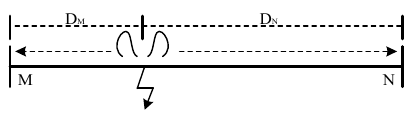
Figure 2. Principle of two-terminal fault location.